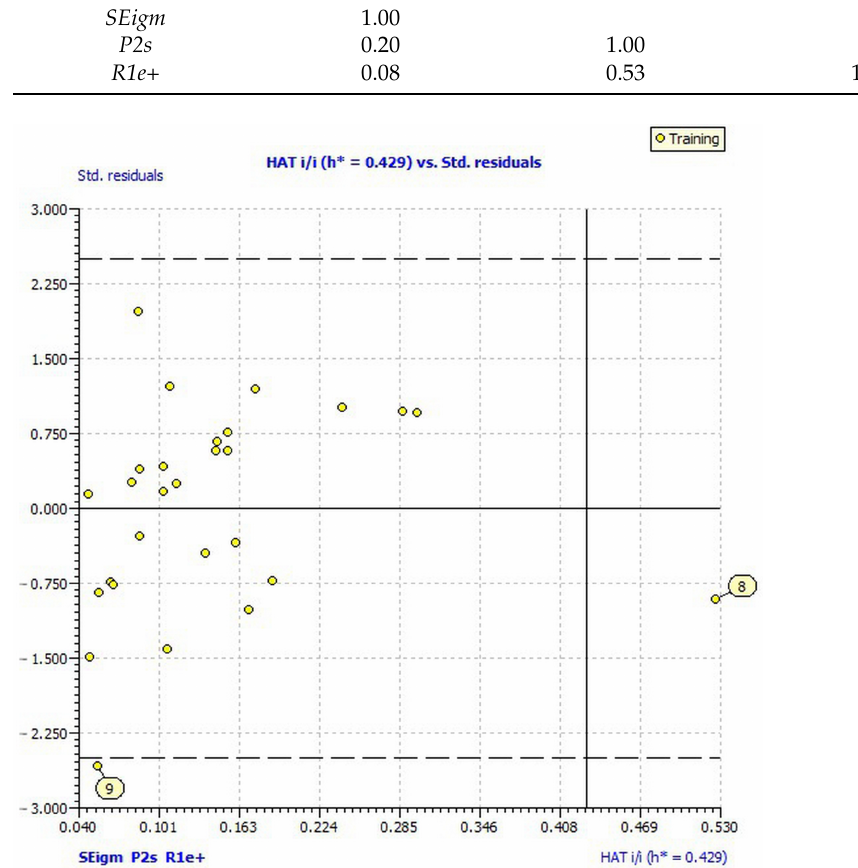
Figure 3. Williams plot of applicability domain of the QSAR model for inhibition of Sclerotinia sclerotiorum calculated by model